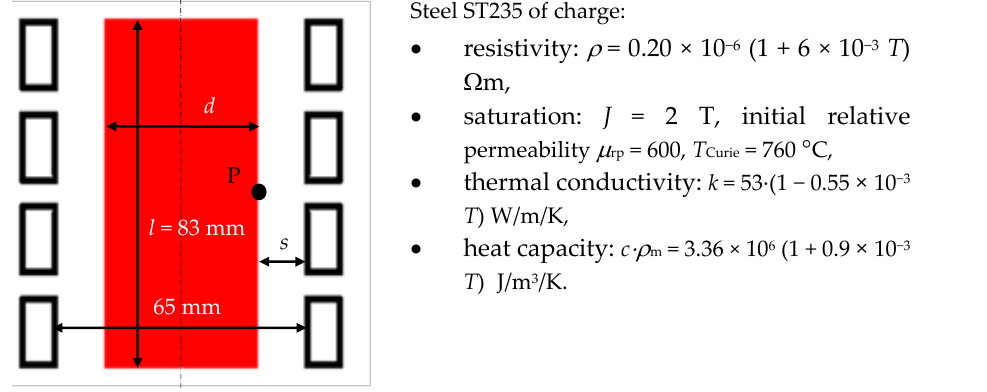
Figure 5. Example of an IHS with a four-turn inductor.